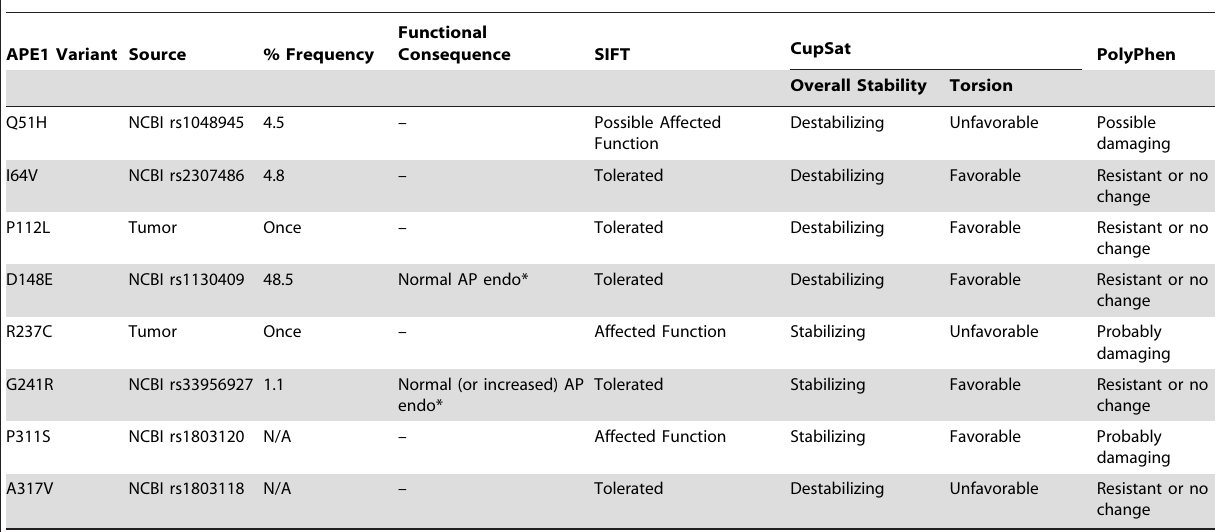
Table 1. APE1 variants and predicted impact of amino acid